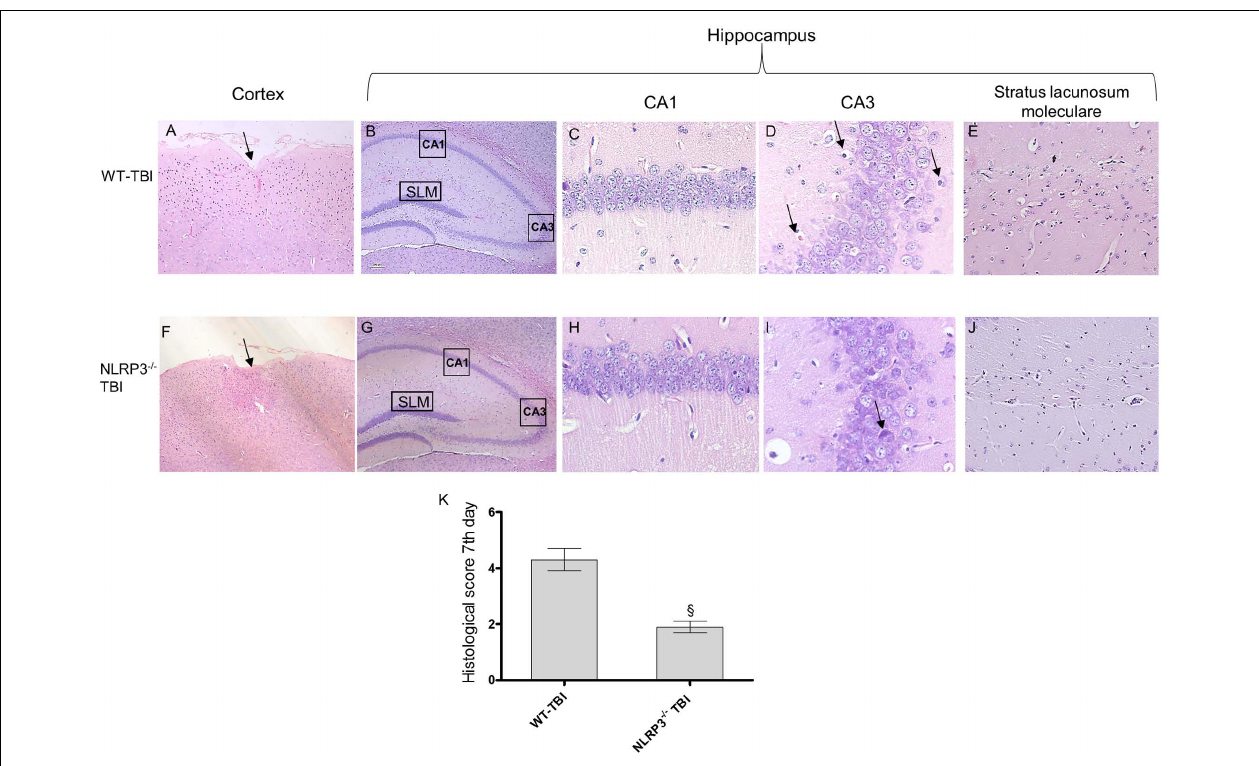
FIGURE 5 | Representative H&E staining of brain tissue from WT and NLRP3 − / − mice 7 days following TBI. (A) Cortex of WT-TBI animal, the arrow indicates the impact point, hemorrhage and edema are still markedly visible. Original magnification X5. (B) hippocampus of WT-TBI animal. The rectangle indicates the Ca1, Ca3, and stratus lacunosum moleculare areas used for enlargement. Original magnification X5. (C) Ca1 area of WT-TBI animal, showing partial restoration of normal architecture with shrank neurons. Original magnification X40. (D) Ca3 area of WT-TBI animal, showing neuronal loss and presence of eosinophil neurons (arrows). Original magnification X40. (E) Stratus lacunosum moleculare of WT-TBI animal, showing partially restored architecture. Original magnification X20. (F) Cortex of NLRP3 − / − -TBI animal, the arrow indicates the impact point, hemorrhage and edema are markedly visible. Original magnification X5. (G) Hippocampus of NLRP3 − / − -TBI animal. The rectangle indicates the Ca1, Ca3, and stratus lacunosum moleculare areas used for enlargement. Original magnification X5. (H) Ca1 area of NLRP3 − / − -TBI animal, showing a preserved architecture, absence of hemorrhage and edema, with few shrank neurons. Original magnification X40. (I) Ca3 area of NLRP3 − / − -TBI animal, showing neuronal loss and presence of eosinophil neurons (arrows). Original magnification X40. (J) Stratus lacunosum moleculare of NLRP3 − / − -TBI animal, showing an almost normal architecture. Original magnification X20. (K) The graph represents the cumulative histological score evaluated at 7 days from each group of animals. § p < 0.05 vs WT-TBI. Each bar represents the mean and SD of seven